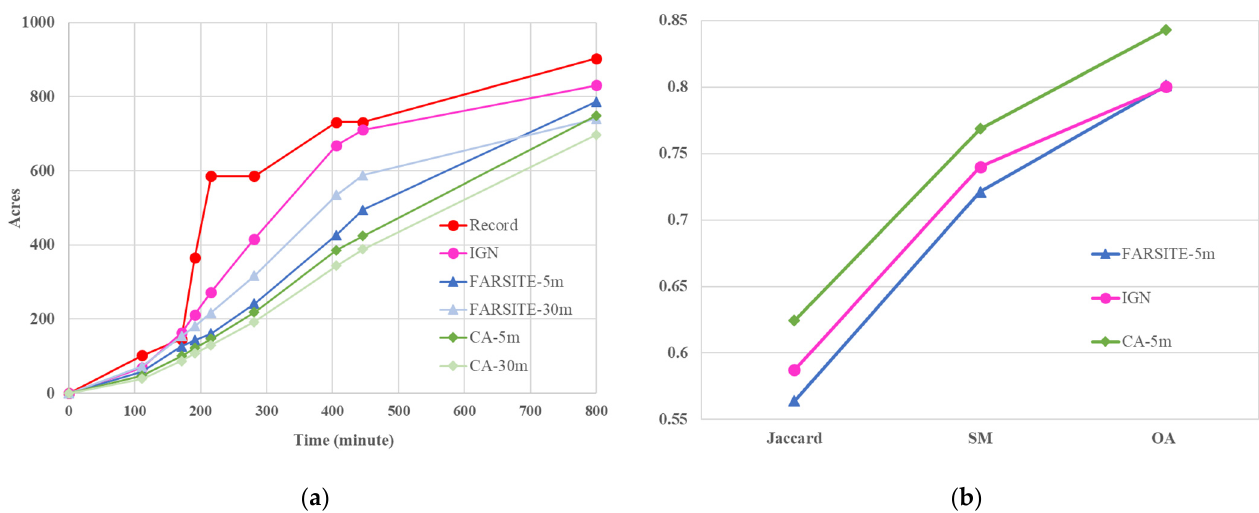
Figure 8. Quantitative comparative analysis. ( a ) Comparison of the burned area at different times; ( b ) comparison of model performance.